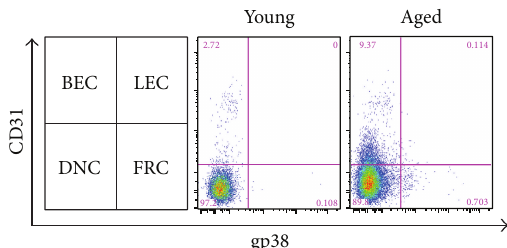
Figure 3: Splenic stromal cell populations of young and aged mice. SPL whole cells from young and aged mice were stained with anti- CD45, anti-CD31, and anti-gp38. Numbers in quadrants indicate percentage of each stromal cell subset among CD45 − cells. The data are the representative of three similar experiments ( 𝑛 = 3 ). Figure 4: IL-6 protein induced by LPS in CD45 − or CD45 + cells.